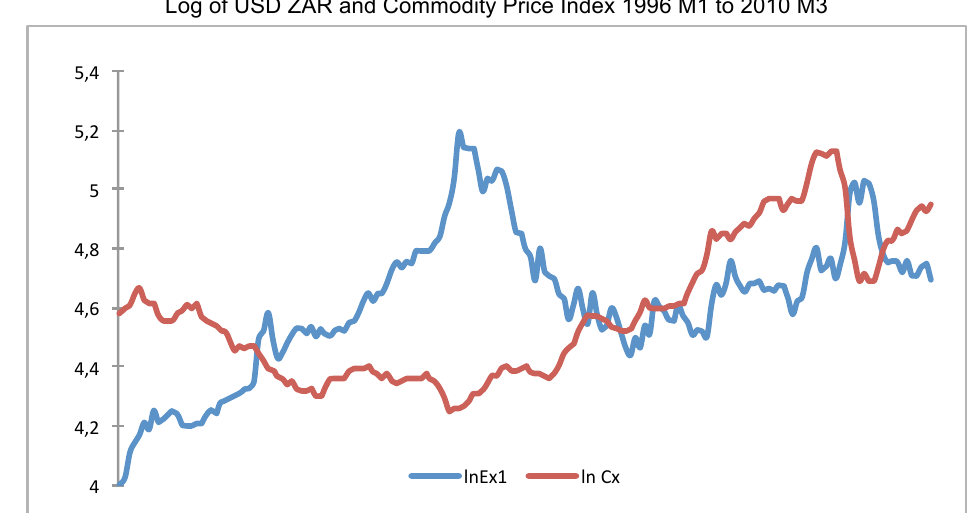
Log of USD ZAR and Commodity Price Index 1996 M1 to 2010